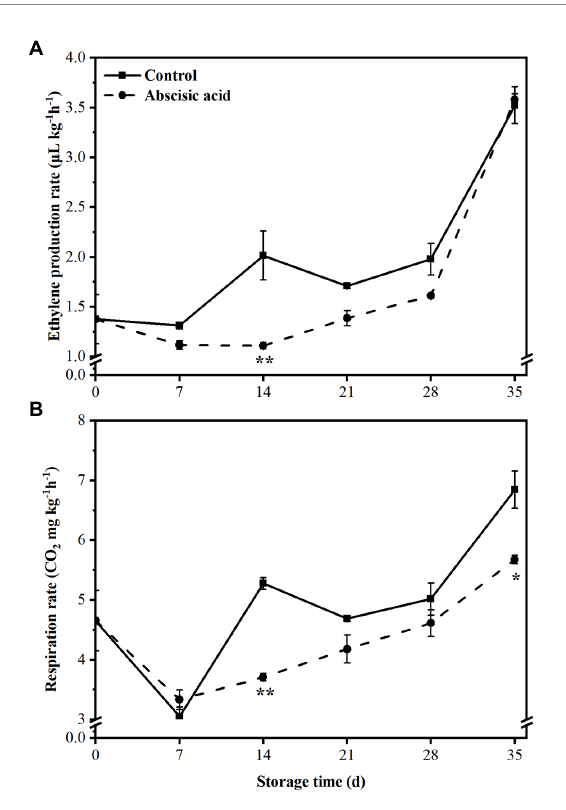
FIGURE 2 Effect of abscisic acid (ABA) treatment on ethylene production (A) and respiration rate (B) of peach fruit during cold storage at 4 ° C. Vertical bars represent the standard deviation of the means of triplicate samples ( n = 3). The symbol (*) indicates significant differences among different treatments at p < 0.05. The symbol ( ** ) indicates significant differences among different treatments at p < 0.01.